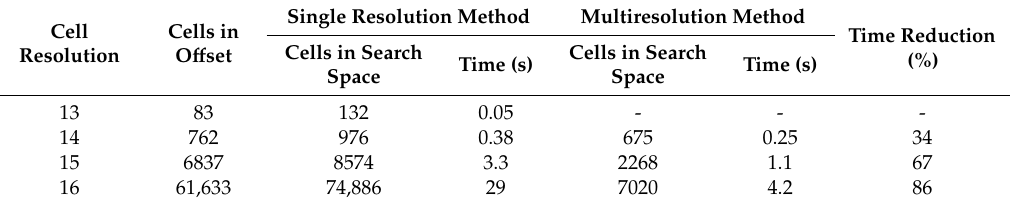
Table 1. Computation speeds for determining cells in the 30 m o ff set region from Figure 8 at di ff erent resolutions.